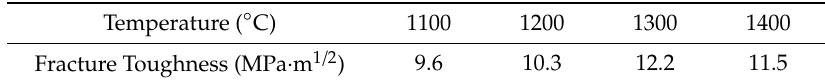
Table 1. Fracture toughness of ultrafine cemented carbides at different sintering temperatures for 40 min.